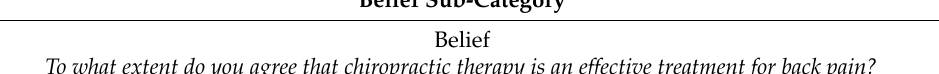
Table 2. Target questions presented in each sub-category with chiropractic–backpain as an example topic. A full list of questions presented in each sub-category can be found in Materials S4 of Supplementary